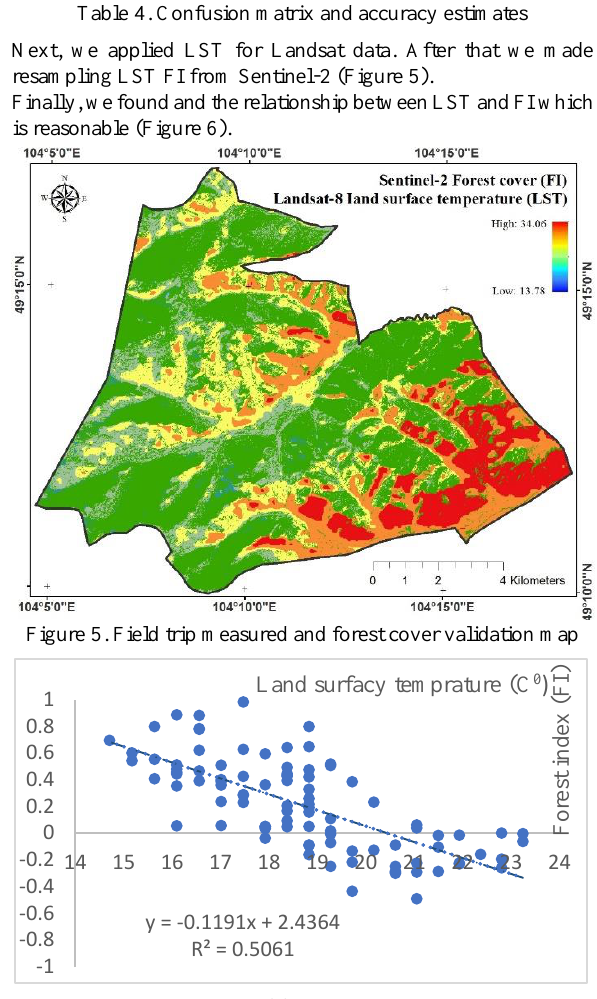
Figure 6. Relationship of forest index threshold and